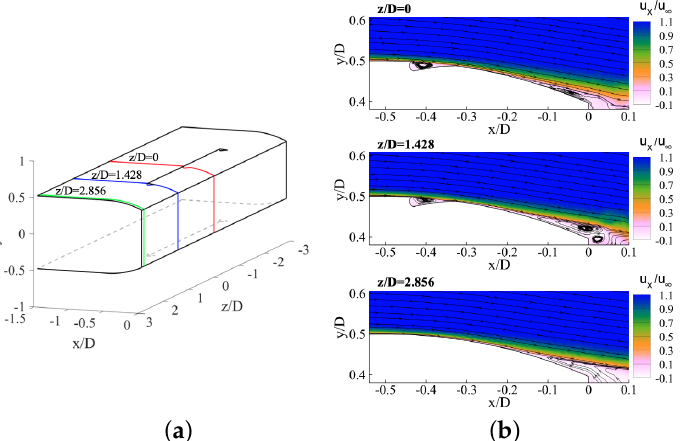
Figure 5. ( a ) Sketch of the considered streamwise sections and ( b ) mean velocity field and streamlines at sections z / D = 0, z / D = 1.428, z / D = 2.856 (from top to bottom) for the case N = 1.